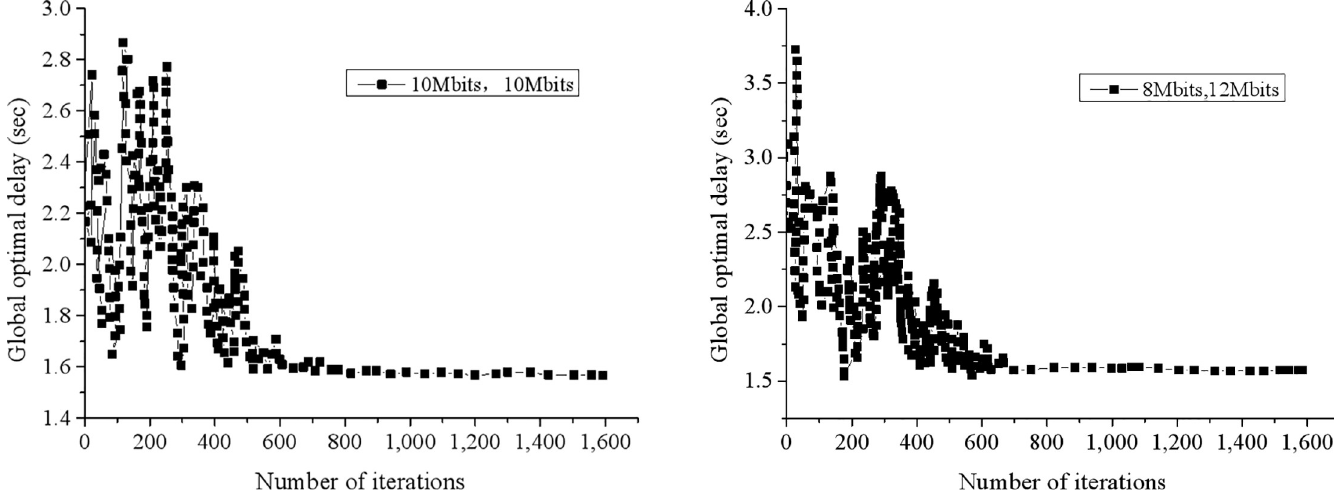
Fig 7. OSAA’s convergence in different computing offload tasks: (a) s up ; 1